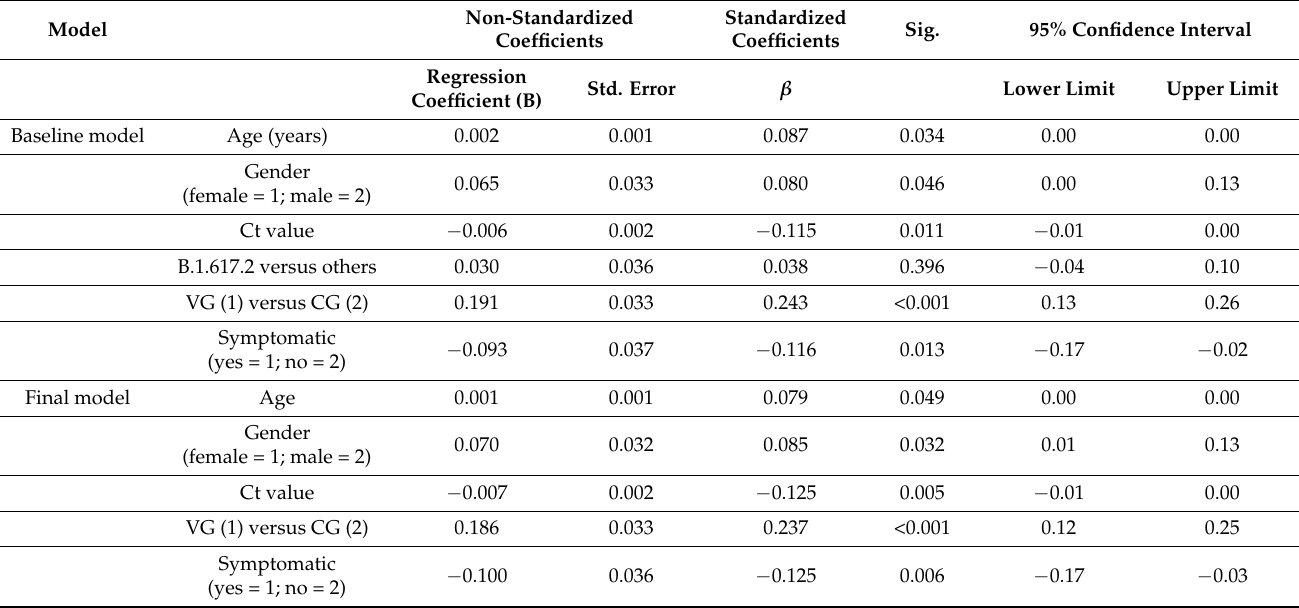
Table 3. Factors influencing the number of infected CPs relative to total CPs.